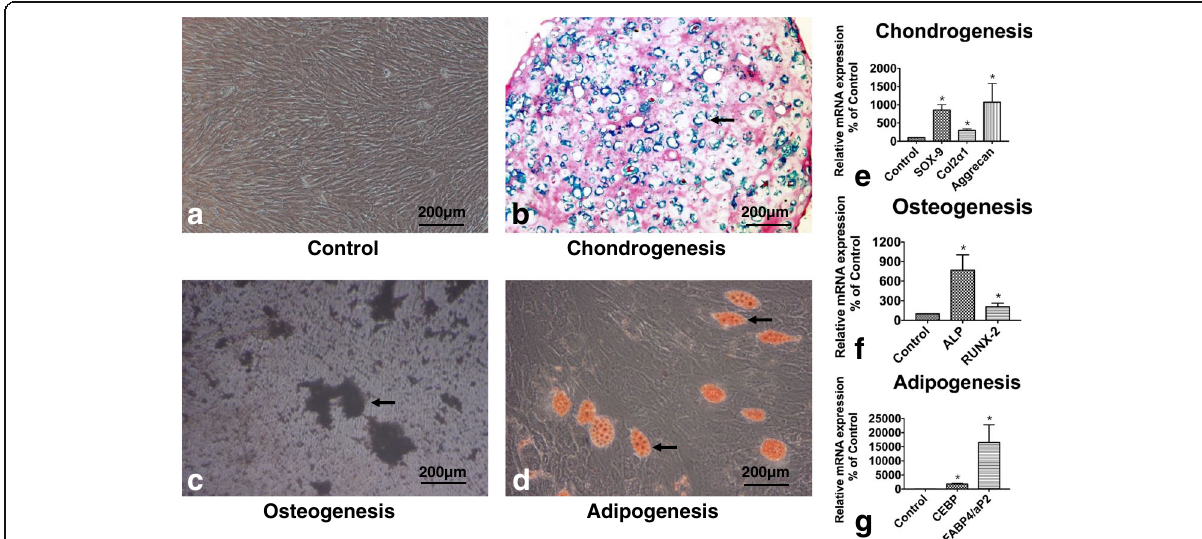
Fig. 2 Determination of multi-differentiation of hUC-MSCs. 2nd passage hUC-MSCs were used for multi-differentiation determination. For osteogenesis or adipogenesis, cells were cultured in 6-wells plate with osteogenic or adipogenic medium for 2 weeks. Chondrogenesis was conducted in pellet culture for 2 weeks ( n = 6). a : control group. b : Chondrogenesis group cells. Hematoxylin-eosin and alcian blue dual-staining (arrow indicated the positive alcian blue staining). c: Osteogenesis group cells (arrow indicated the positive von Kossa staining). d : Adipogenesis group cells (arrow indicated the positive oil red O staining). The results showed here were representative of all samples from 6 donors. The expression of differentiation related genes was evaluated by qRT-PCR. e : Chondrogenesis related genes. f: Osteogenesis related genes. g: Adipogenesis related genes. Data was analyzed by using the 2 - ΔΔ CT method.